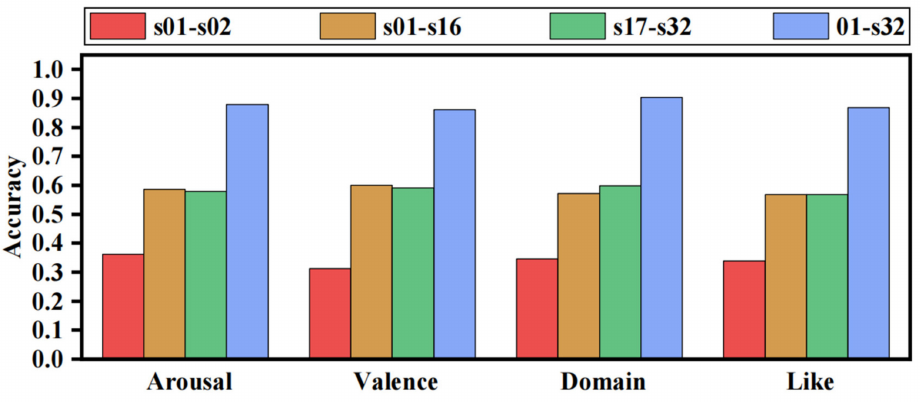
Figure 4. The accuracy of the models trained from the four DEAP data on the test set shows.